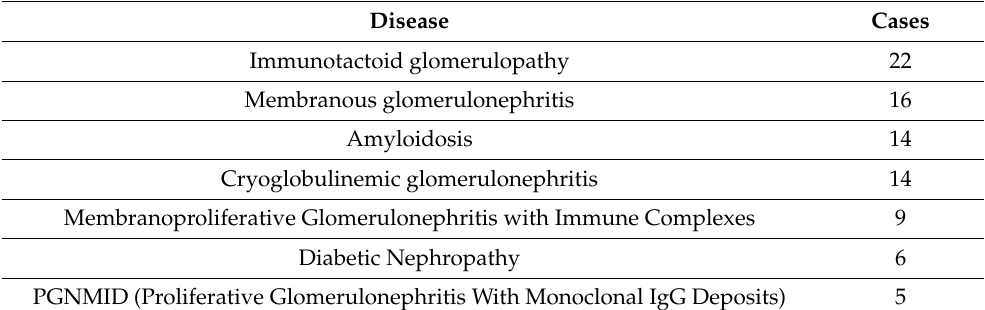
Table 1. Control group